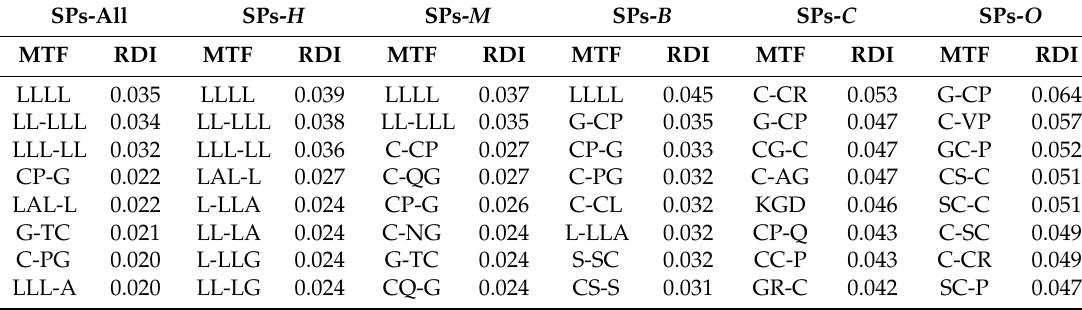
Table 1. The top 20 informative motifs in various datasets. ‘-’ denotes arbitrary 20 amino acids. SPs-All